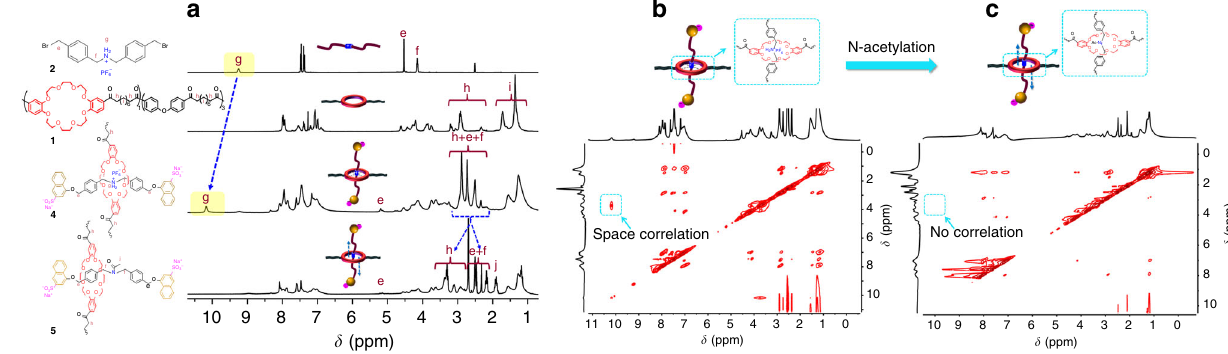
Fig. 2 Probing host – guest interaction in the rotaxane based polymer assembly. a 1 H-NMR spectra (from top to bottom) of linear axles precursor 2 , (400 MHz, DMSO-d 6 , 298 K), the poly(crown ether) 1 , (400 MHz, CDCl 3 , 298 K), polyrotaxane 4 (assembled from the 1 and 2 via host – guest interaction, 400 MHz, DMSO-d 6 , 298 K) and N-acetylated polyrotaxane, 5 (400 MHz, DMSO-d 6 , 298 K). b NOSEY spectrum of polyrotaxane 4 from the assembly of 1